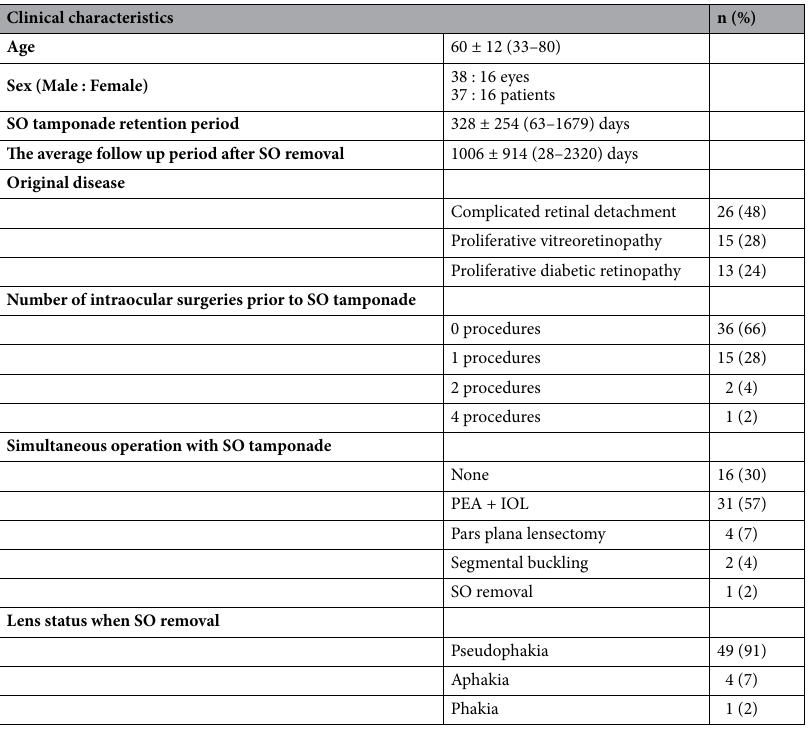
Table 1. Demographic data of the SO removal eyes. SO, silicone oil; PEA, phacoemulsification; IOL, intraocular